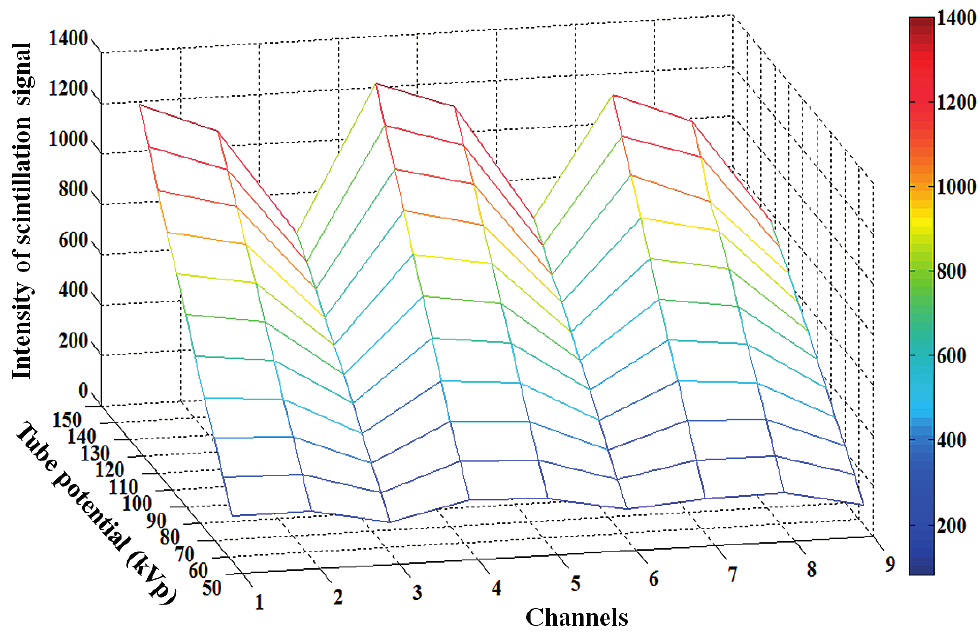
Figure 4. 3D intensity variation of nine scintillation signals measured by using the proposed phantom dosimeter at each measuring point in accordance with the tube